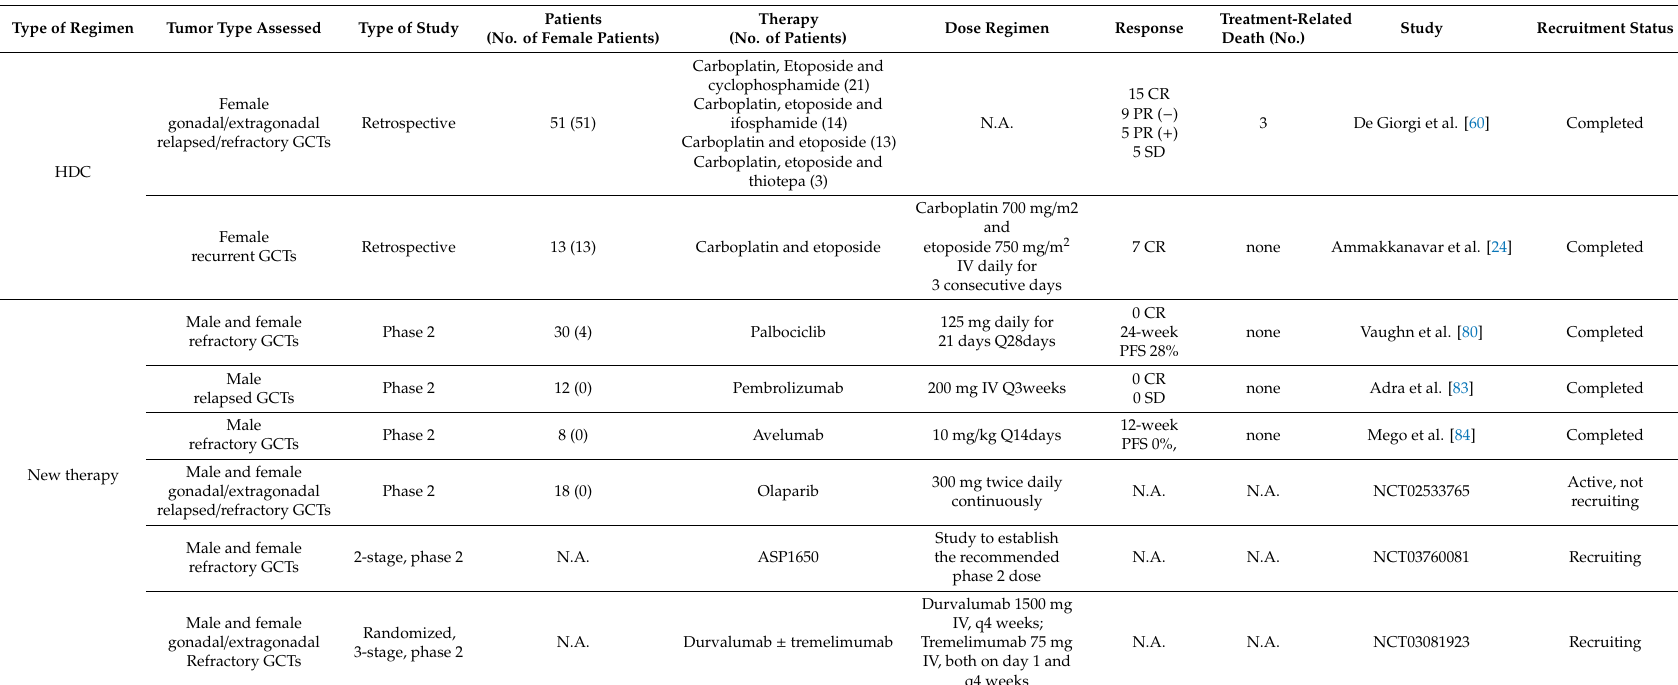
Table 3. Principal studies for treatment of relapsed / refractory